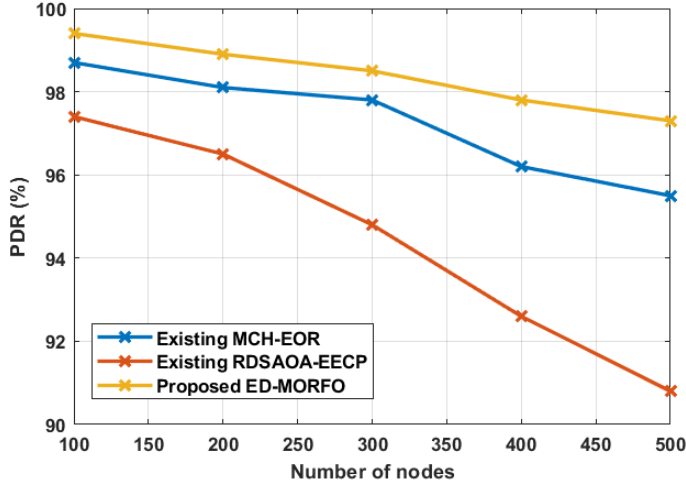
Figure 4. Performance of PDR for proposed EDMORFO and Existing MCH-EOR [24], RDSAOA- EECP [25]. Table 3. Performances of